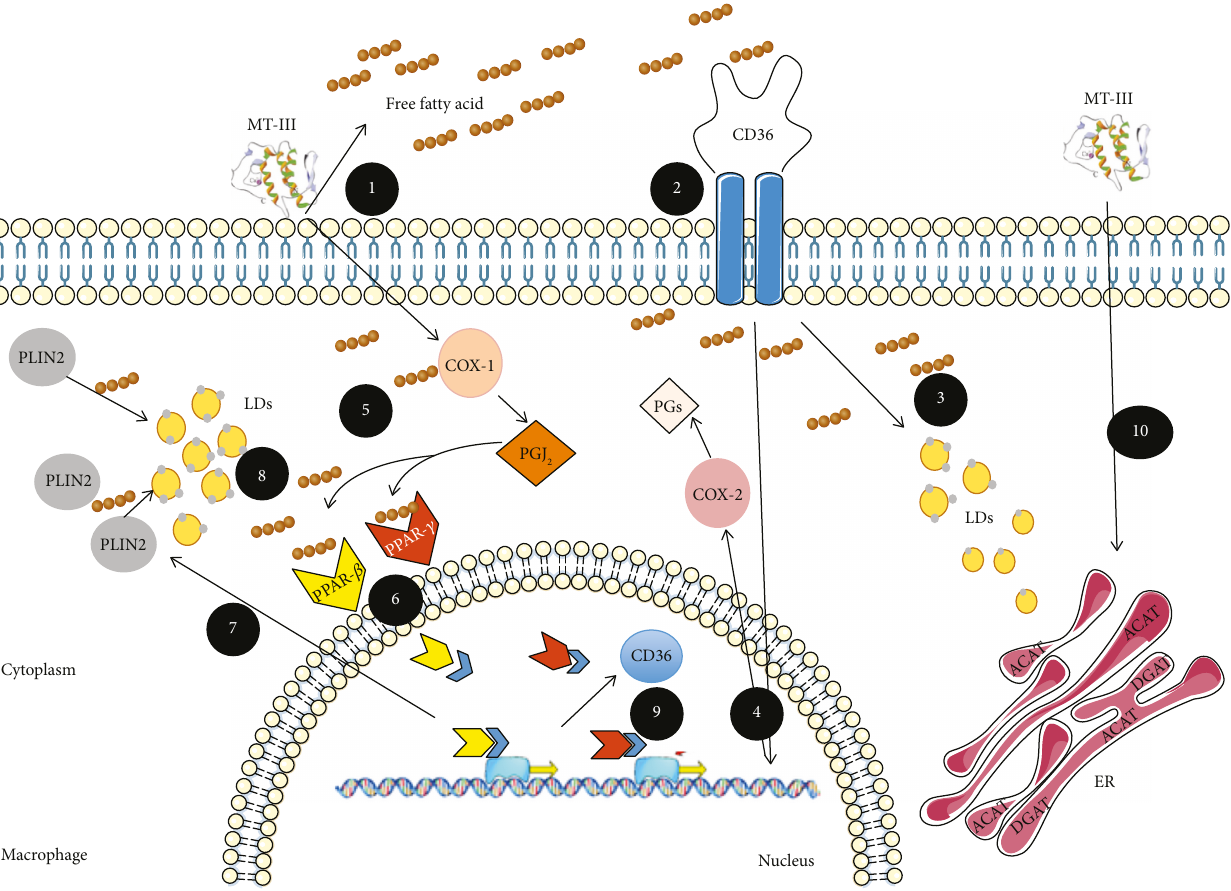
Figure 8: Schematic illustration of the mechanisms involved in foam cell formation induced by MT-III a GIIA snake venom sPLA III by acting on cellular membrane of macrophages generates free fatty acids, which will be internalized by CD36 scavenger receptors; (2) activation of C36 receptor leads to formation of (3) lipid droplets and (4) expression of COX-2. (5) MT-III induces production of 15-d-PGJ via COX-1 pathway (6). This mediator and free fatty acids activate the cytoplasmic transcription factors PPARs; (7) PLIN2, 2 sca ff old protein for lipid droplet assembly, is under transcriptional control of PPAR- β / δ and favors the increase of (8) lipid droplet formation. (9) Both PPAR- γ and PPAR- β / δ upregulate CD36 protein expression forming a positive loop for generation of lipid droplets in macrophages. (10) MT-III also activates endoplasmic reticulum enzymes (DGAT and ACAT) crucial for formation of lipid